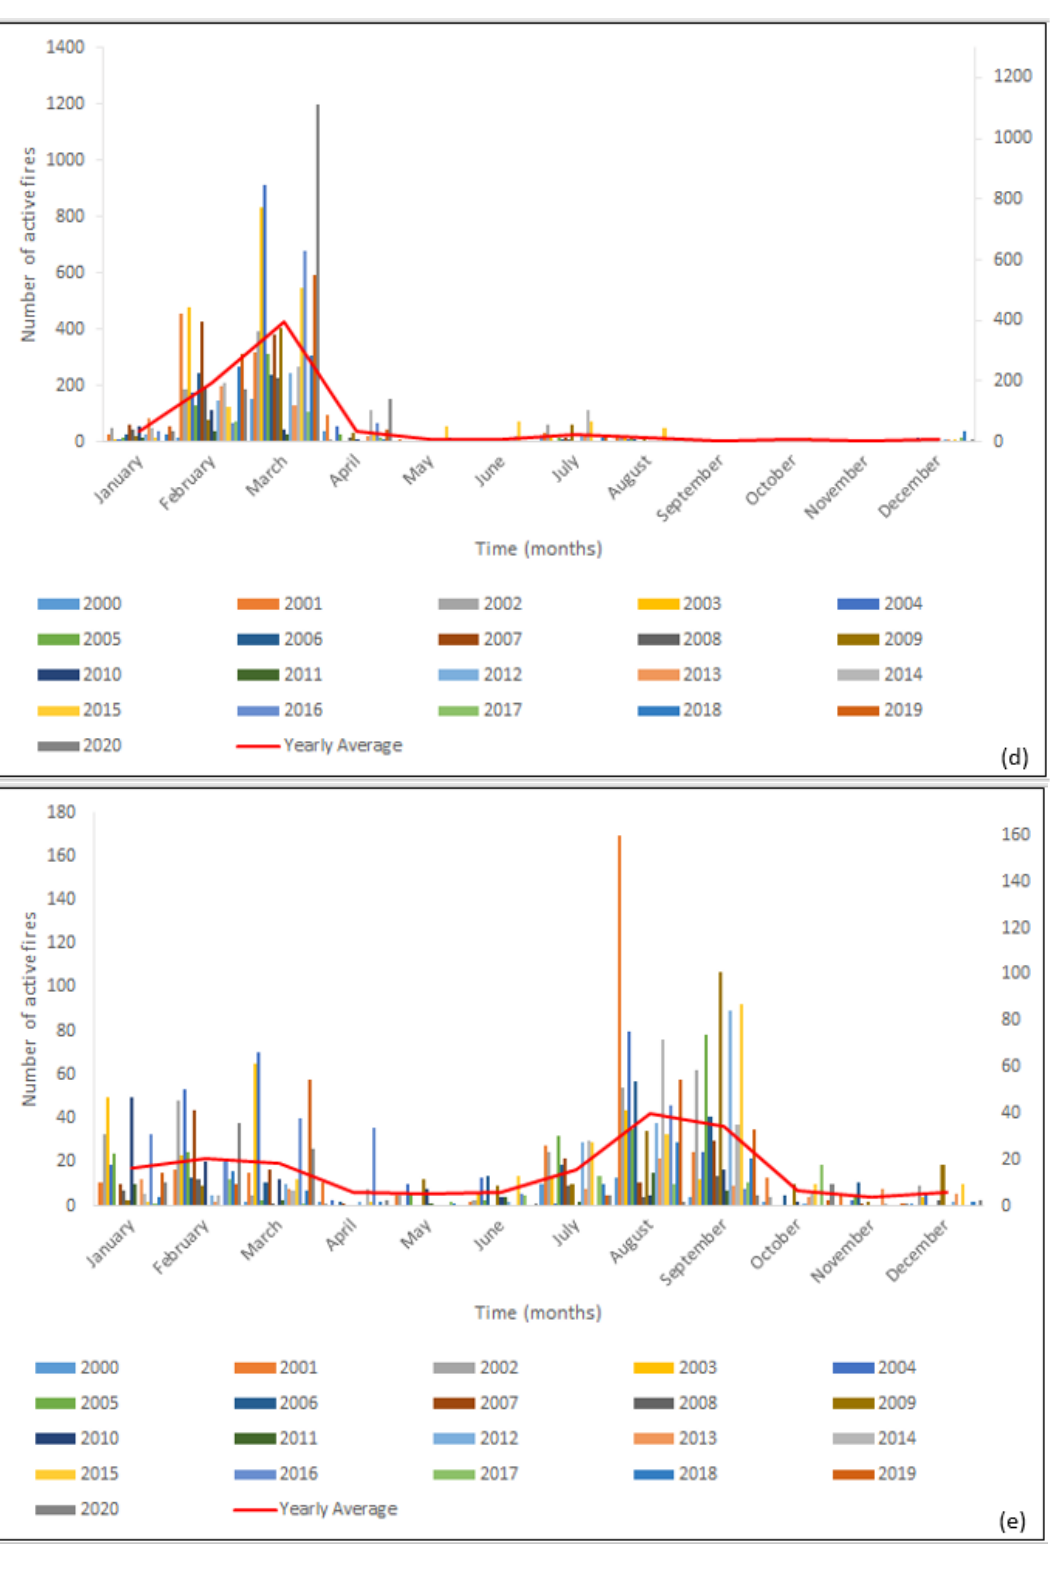
Figure 6. Temporal distribution of fire occurrence by month in Colombia regions: ( a ) Orinoquia; ( b ) Amazon; ( c ) Andean; ( d ) Caribbean; ( e ) Pacific.